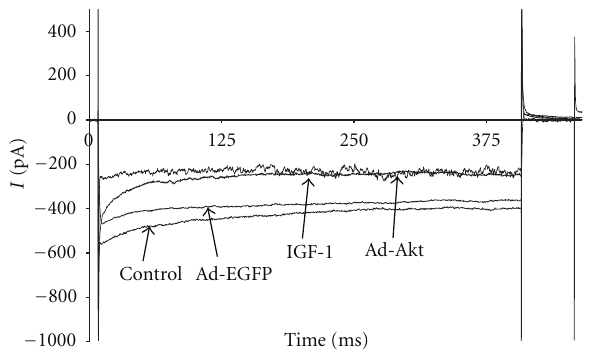
Figure 6: Recording representative of the time courses for the e ff ects of IGF-1 and Ad.Akt treatments in I K1 of normal neonatal rat cardiomyocytes at the clamp voltage of − 120